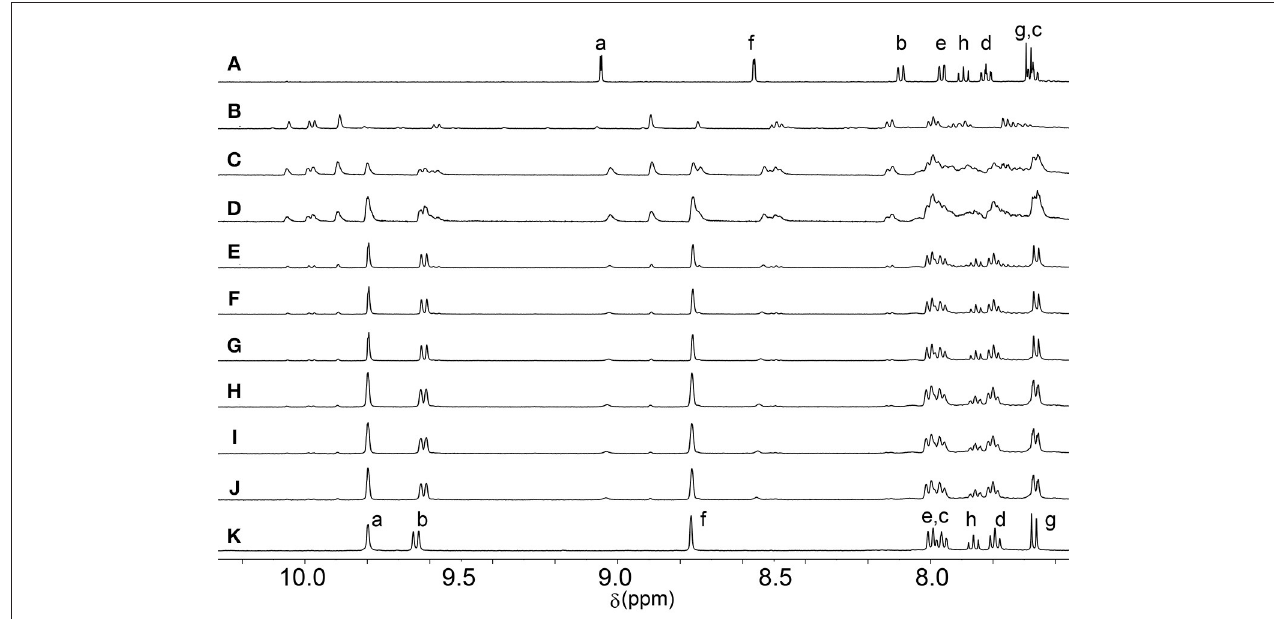
FIGURE 2 | Partial 1 H NMR (500 MHz, CD 3 CN, 338K) spectra showing the formation of C q over time at 65 ◦ C. (A) L q , (B) initial complexation ( t = 0), (C) t = 30min, (D) t = 1h, (E) t = 2h, (F) t = 3h, (G) t = 4h, (H) t = 5h, (I) t = 6h, (J) t = 7h, (K) isolated C q